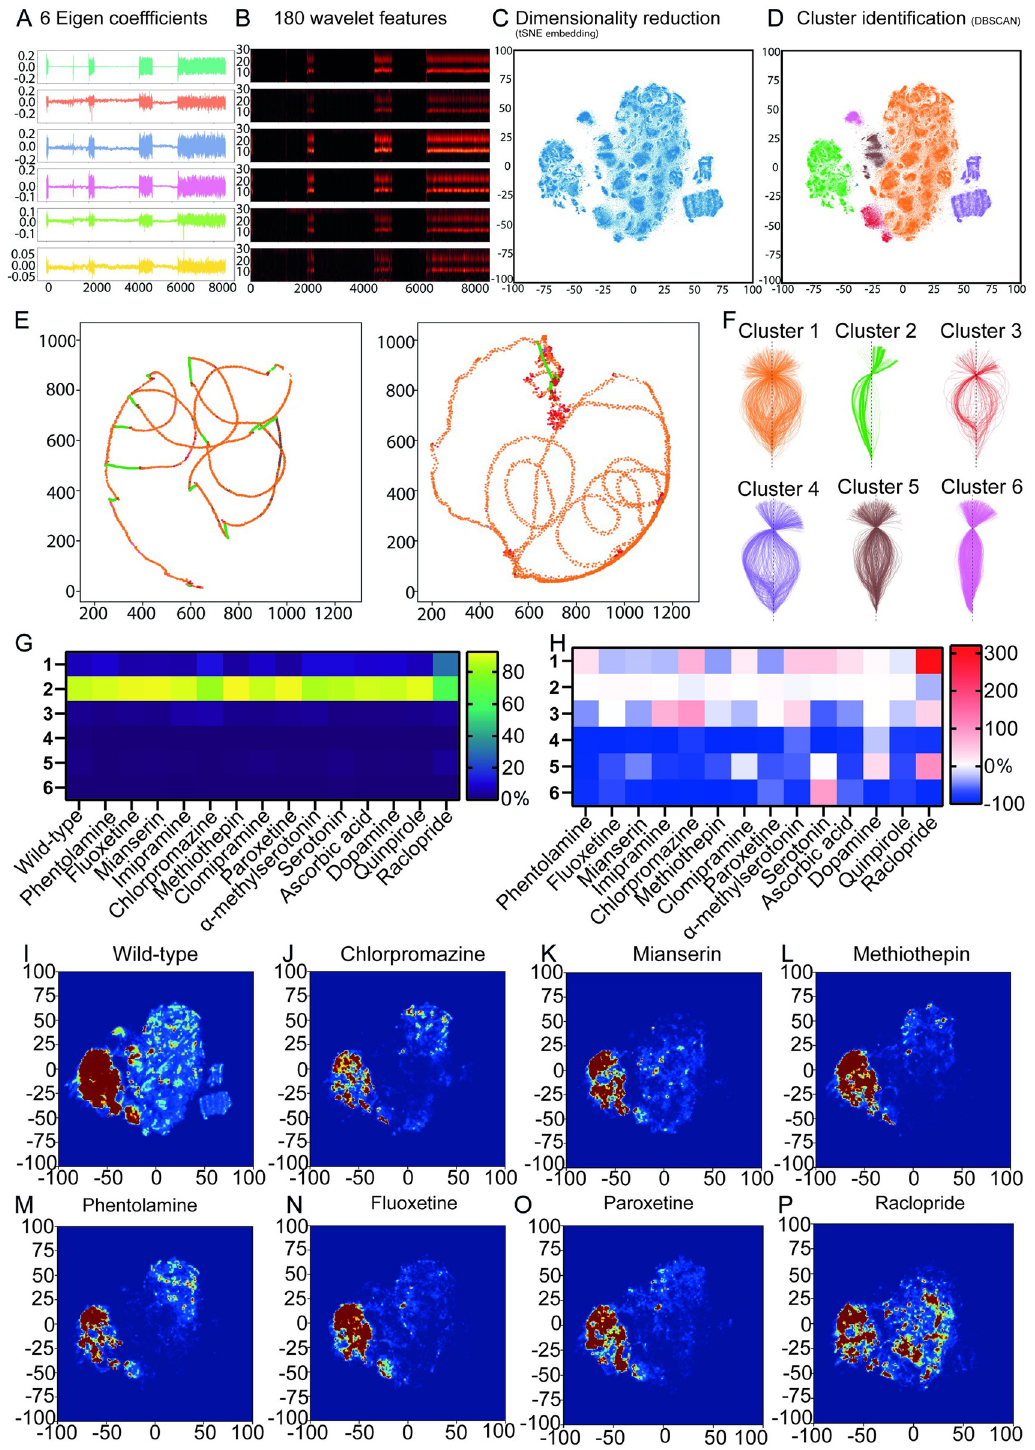
Fig 5. Spatiotemporal embedding uncovers the influence of neuromodulators on stereotyped behaviors. (A) We used the 6 eigencoefficients we previously obtained to define a 6-dimensional input feature space. (B) We computed wavelet transforms of these features over 30 frequencies for the wild-type dataset. Wavelet transform of the 6D eigencoefficient time series of panel A shown. (C) Dimensionality reduction was applied using tSNE to embed the 180-dimensional wavelet features into a 2D space of behavior. (D) We then used the DBSCAN algorithm to cluster into regions based on their density. (E) Examples of neck point